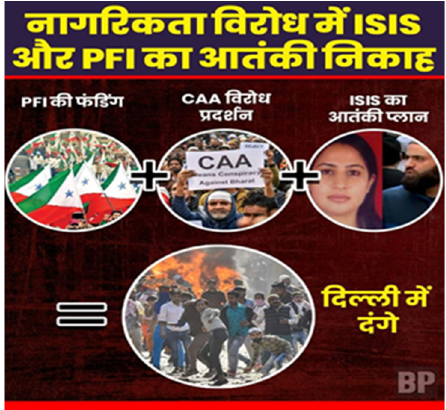
Figure 9. Meme circulated after the arrest of IS inspired couples, alleges the following link: PFI funding + CAA protests + IS’s plan to recruit the couple = riots in Delhi.